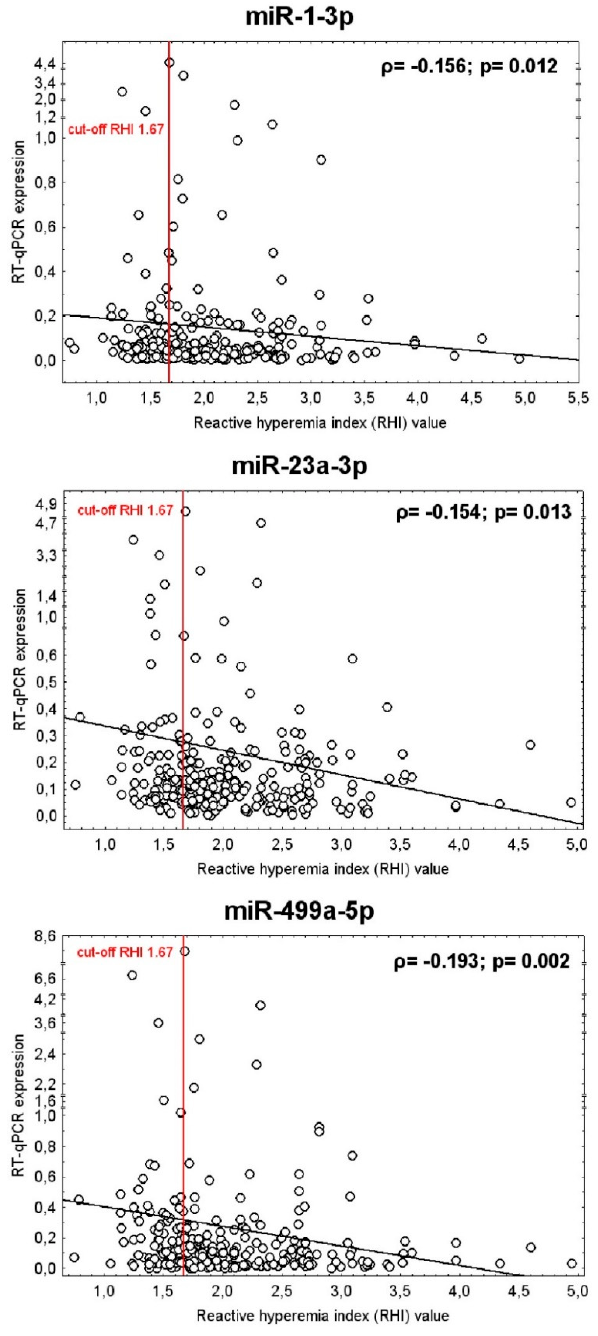
Figure 4. Association between the vascular endothelial function (RHI values) and the expression of miR-1-3p, miR-23a-3p, and miR-499a-5p in whole peripheral blood of young and middle-aged women. Correlation between variables was calculated using the Spearman’s rank correlation coe ffi cient ( ρ ). Spearman’s rank correlation coe ffi cient, a nonparametric measure of rank correlation, assesses how well the relationship between two variables can be described using a monotonic function. The significance level was established at a p -value of p < 0.05. The RHI values showed a week negative correlation with the expression of miR-1-3p, miR-23a-3p, and miR-499a-5p in whole peripheral blood of young and middle-aged women. That means that women with a finding of lower RHI values showed significantly increased levels of miR-1-3p, miR-23a-3p, and miR-499a-5p in whole peripheral blood, respectively.